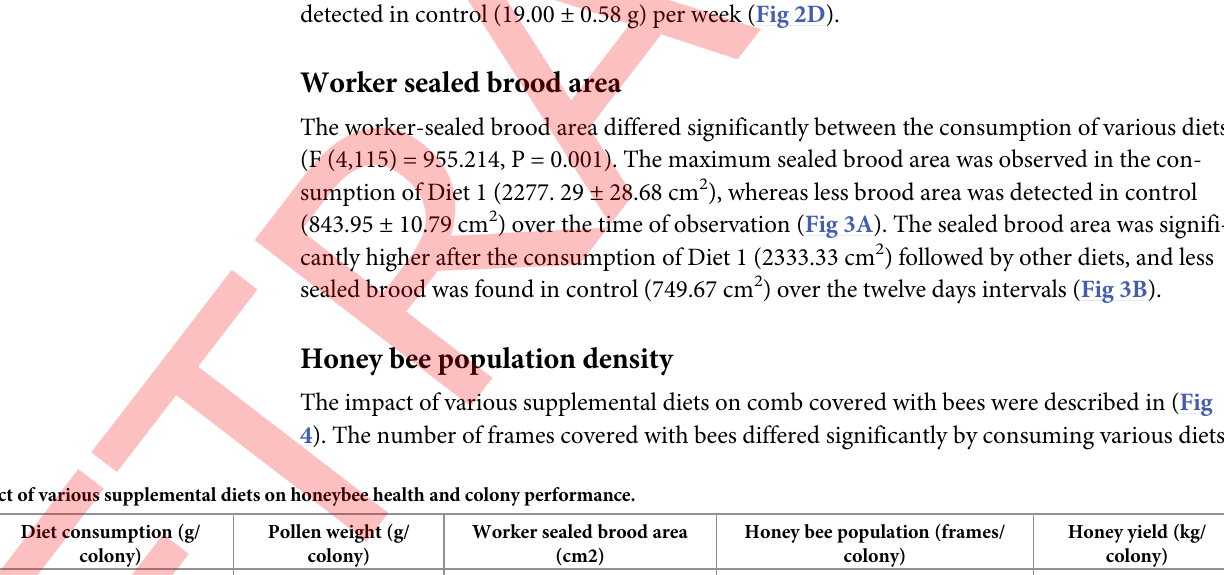
Table 1. Effect of various supplemental diets on honeybee health and colony performance. Treatment Diet consumption (g/ Pollen weight (g/ Worker sealed brood area Honey bee population (frames/ Honey yield (kg/ colony) colony) (cm2) colony) colony) Mean ± S. Error Mean ± S. Error Mean ± S. Error Mean ± S. Error Mean ± S. Error Diet 1 106.08 ± 2.15 a